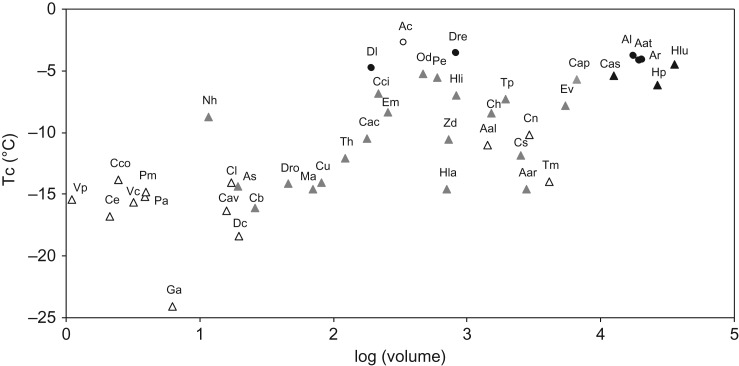
Relationships between the temperature of crystallization (Tc) and the volume of 43 species of slugs and snails. Triangles indicate shelled species and circles slugs. White symbols indicate freeze-intolerant species, black symbols partly freeze-tolerant or freeze-tolerant species and grey symbols indicate species with unknown cold-tolerance strategy. Data are from Ansart et al. (2014) and personal observations A.A. except for species Dl and Ac (Storey et al., 2007), Dre (Cook, 2004), Al, Aat and Ar (Slotsbo et al., 2012), Aal (Riddle, 1981), Dc and Ga (Riddle and Miller, 1988), Cav (Koštál et al., 2013), Vp (Schmid, 1988) and Aar (Stöver, 1973), Tm (Franke, 1985). Sample size ranges from five to 110 individuals depending on species. Only Tc values obtained during the cold season have been considered. Volume was estimated as the mean between the volume of a cone and that of an ellipsoid for shelled snails (see Ansart et al., 2014) and as the volume of a cylinder for slugs. Mean size estimations were extracted from Welter-Schultes (2012), Kerney and Cameron (1999) and Rowson et al. (2014) for European species and from Pilsbry (1940, 1948) for American species. Abbreviations: Aal, Anguispira alternata; Aar, Arianta arbustorum; Aat, Arion ater; Ac, Arion circumscriptus; Al, Arion ‘lusitanicus’ = vulgaris (invader); Ar, Arion rufus; As, Abida secale; Cac, Cochlicella acuta; Cap, Cantareus apertus; Cas, Cornu aspersum; Cav, Chondrina avenacea; Cb, Clausilia bidentata; Cci, Ciliella ciliata; Cco, Columella columella; Ce, Columella edentula; Ch, Cepaea hortensis; Cl, Cochlicopa lubrica; Cn, Cepaea nemoralis; Cs, Cepaea sylvatica; Cu, Candidula unifasciata; Dc, Discus cronkhitei; Dl, Deroceras laeve; Dre, Deroceras reticulatum; Dro, Discus rotundatus; Em, Ena montana; Ev, Eobania vermiculata; Ga, Gastrocopta armifera; Hla, Helicigona lapicida; Hli, Hygromia limbata; Hlu, Helix lucorum; Hp, Helix pomatia; Ma, Macrogastra attenuata; Nh, Nesovitrea hammonis; Od, Oxychilus draparnaudi; Pa, Pupilla alpicola; Pe, Pomatias elegans; Pm, Pupilla muscorum; Th, Trochulus hispidus; Tp, Theba pisana; Vc, Vallonia costata; Vp, Vallonia perspectiva; Wm, Triodopsis (Webbhelix) multilineata; and Zd, Zebrina detrita.